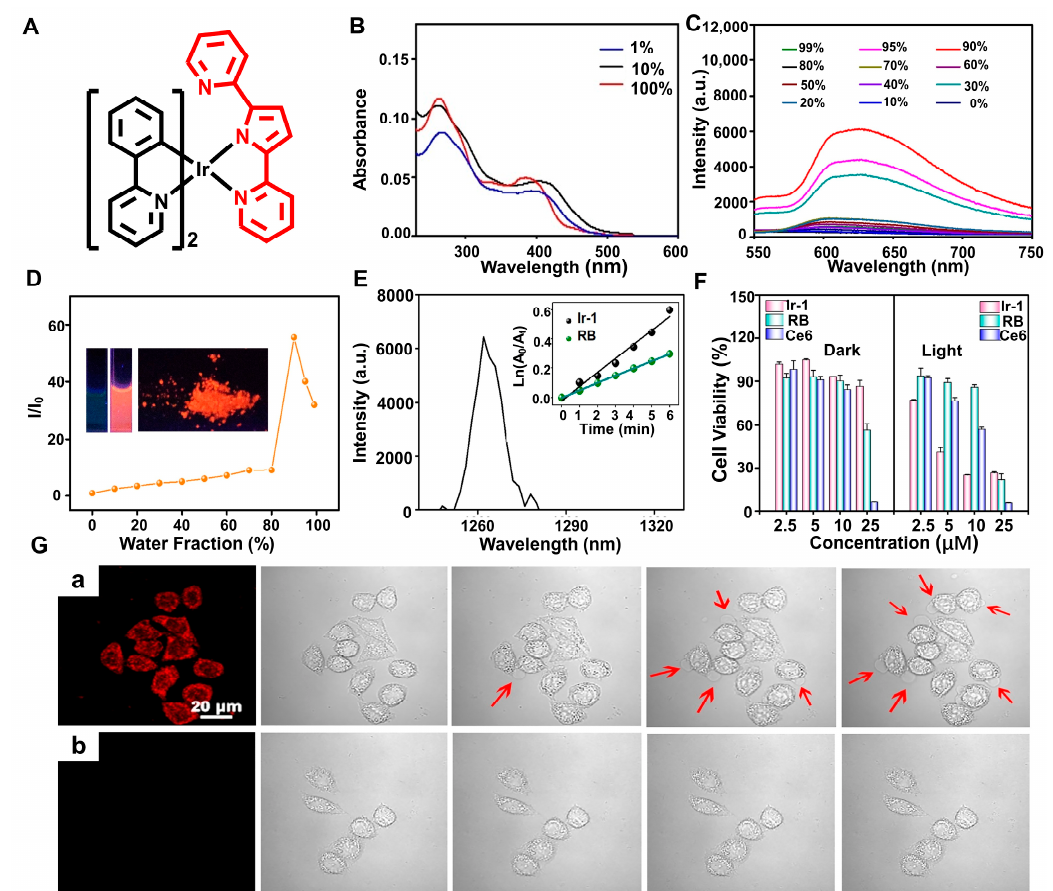
Figure 1. ( A ) The molecular structure of 1 . ( B ) Solution UV-vis absorbance spectra of 1 in EtOH/water (fractions of EtOH 1%, 10% and 100%). ( C ) Phosphorescence spectra of 1 in EtOH/water (fractions of water ranged from 0 to 99%). ( D ) Variation in PL intensity in EtOH/water mixtures with f w . ( E ) The phosphorescence spectrum of 1 O 2 . ( F ) The cytotoxicity and phototoxicity of 1 , Ce6 and RB to Hela cells. ( G ) CLSM images of Hela cells in the (a) presence (the red arrows: blebs were emerged around the cytomembrane) and (b) absence of 1 and their laser irradiation time-dependent bright-field images. Reprinted with permission from [44] , copyright 2021, Wiley-VCH.